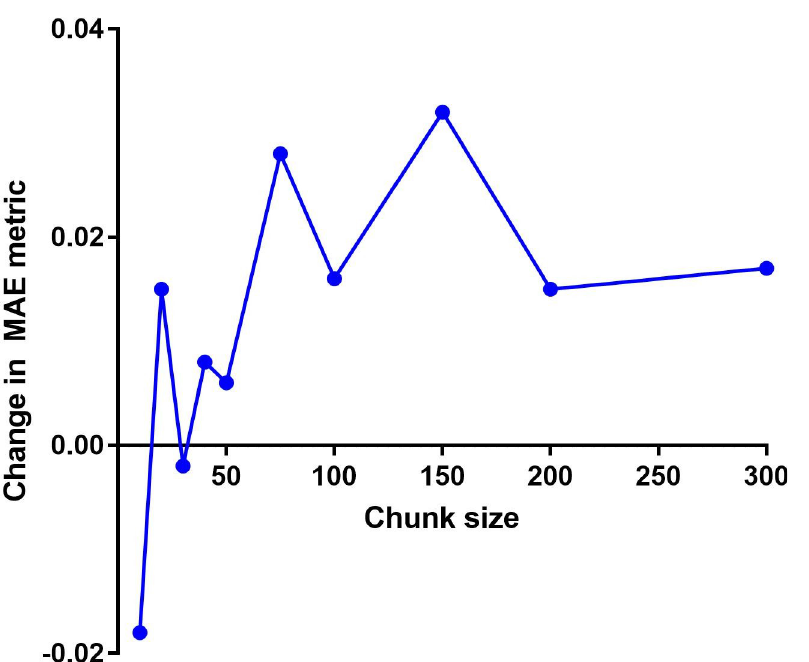
Fig 7. Changes in MAEs for different chunk-max pooling architectures.